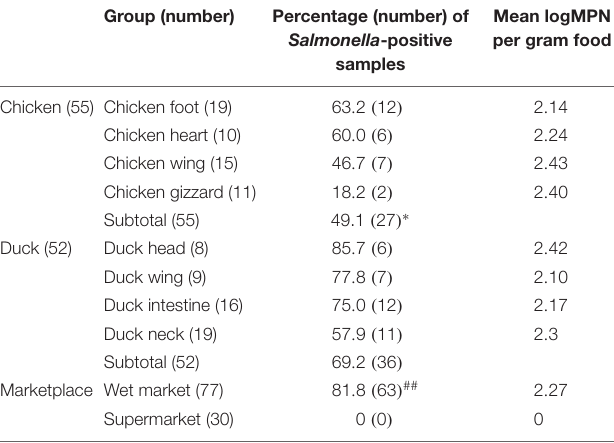
∗ Indicates significant differences in the detection rate of Salmonella-positive samples between chicken and duck products ( ∗∗ p < 0.01, ∗ p < 0.05). ## Indicates highly significant differences in the detection rate of Salmonella-positive samples between wet markets and supermarkets ( ## p < 0.01).